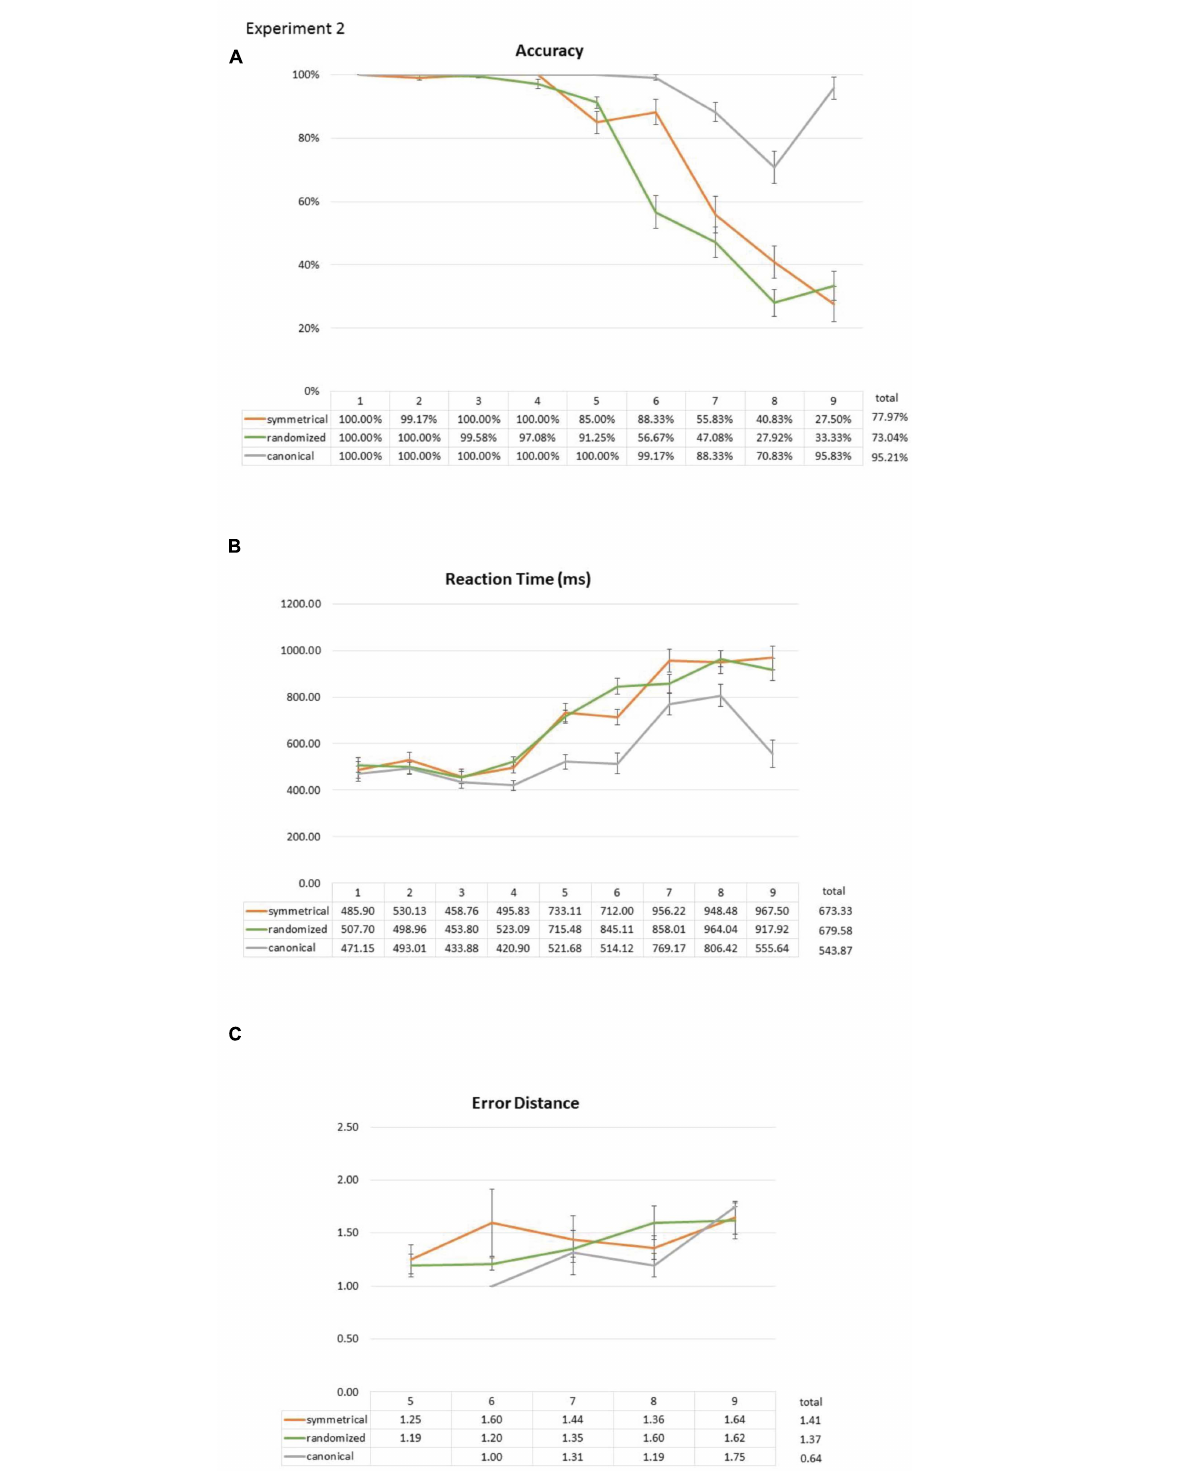
Frontiers in Psychology |